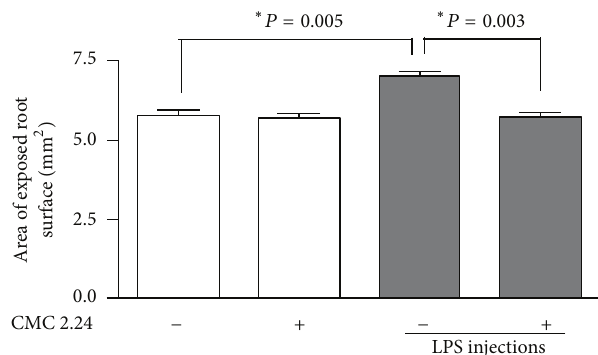
Figure 3: Direct measurements on defleshed hemimaxillae demon- strate that CMC 2.24 significantly inhibits alveolar bone resorption in the in vivo model of LPS-induced periodontal disease. The bar graph presents the results of the percent of exposed root surface, which is directly proportional to the extent of bone loss, according to the experimental group. LPS caused bone loss as indicated by the significant increase of the area of exposed root surface, whereas simultaneous systemic administration of CMC 2.24 significantly reduced this area, indicating an attenuation of inflammatory-driven bone resorption. Differences between experimental conditions are indicated by the brackets and ∗ (unpaired 𝑡 -test for independent samples with Welch’s correction for unequal